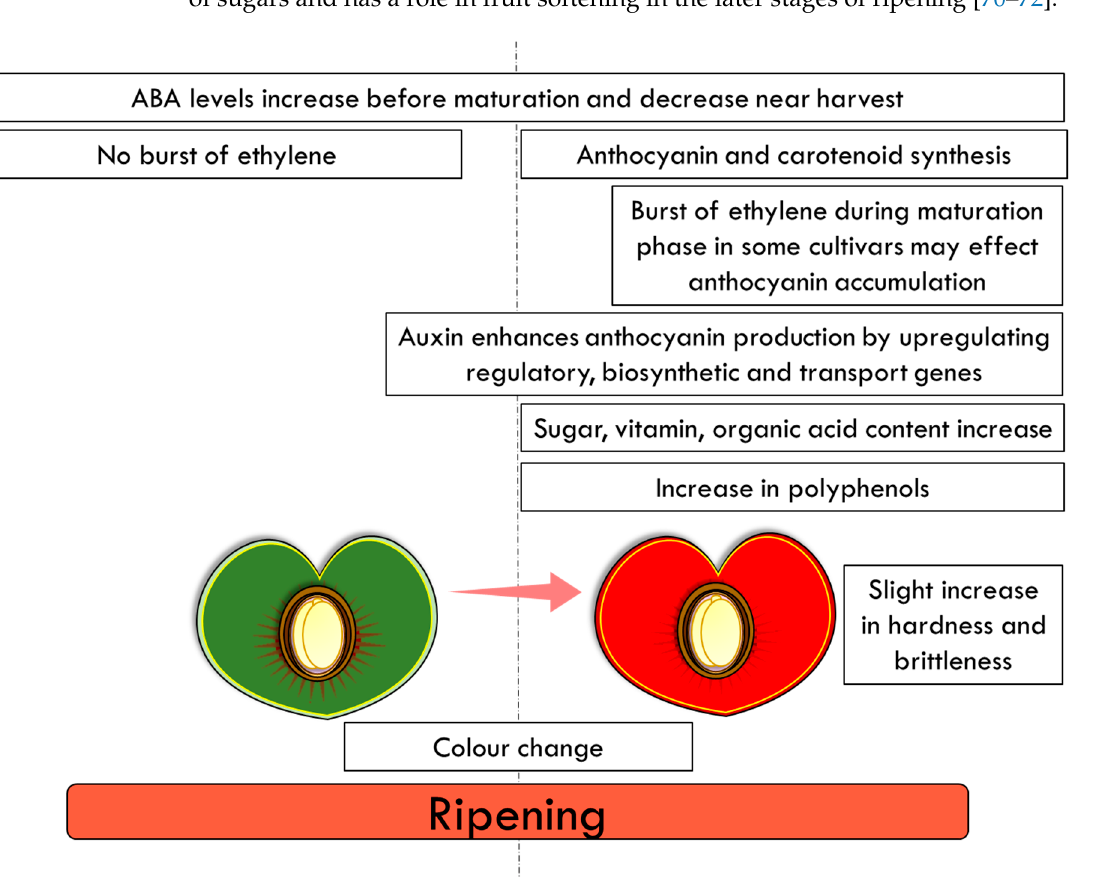
Figure 5 . Final stages of fruit ripening in the cultivated cherry. Figure 5. Final stages of fruit ripening in the cultivated